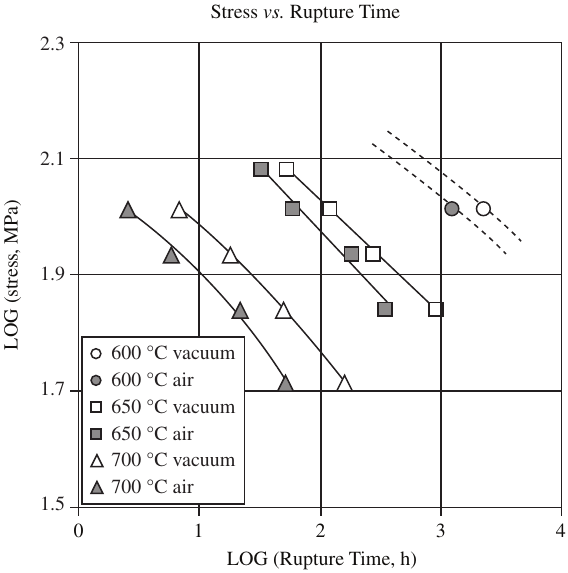
Figure 6. Variation of creep strength with rupture time for 2.25Cr-1Mo steel, in air and vacuum.